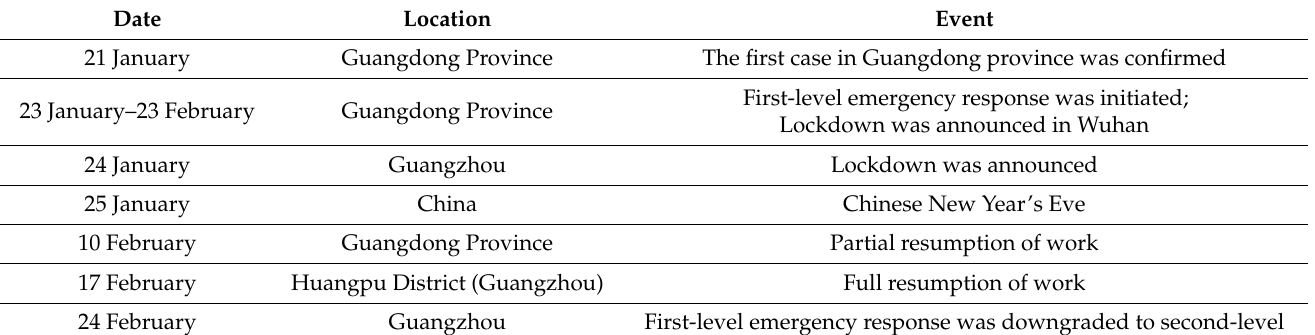
Table 1. Major events happened in Guangdong province in relation to COVID-19 during 21